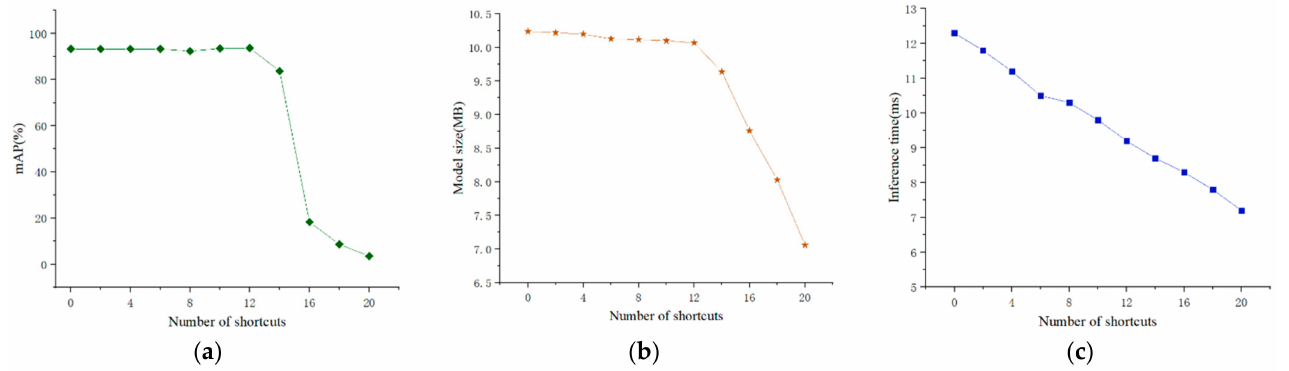
Figure 9. The value of the mAP score, model size, and inference time under a different number of shortcuts. ( a ) Model mAP curve. ( b ) Dimension size curve. ( c ) Inference time